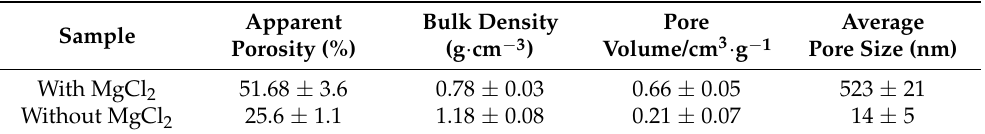
Table 1. Effect of MgCl 2 on the pore structure parameters of carbonized product.